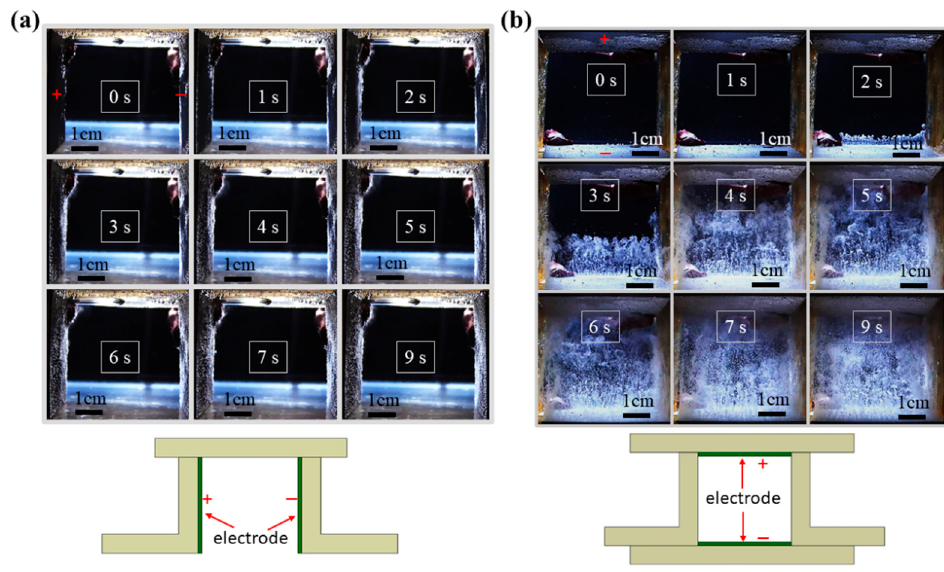
Figure 1. Sequential images of the evolution of gas bubbles on the surface of platinum electrodes that are placed in ( a ) a vertical and ( b ) a horizontal layout without a magnet (voltage: 200 V; electrode distance: 5 cm).